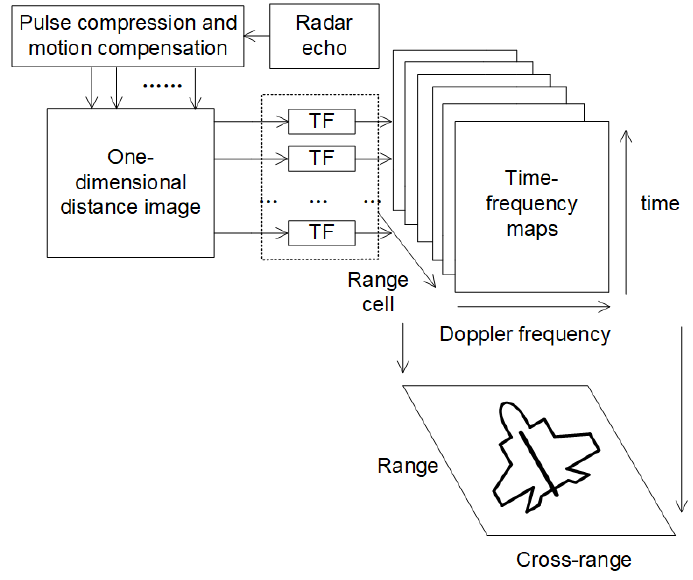
Figure 2. The process of ISAR time-frequency